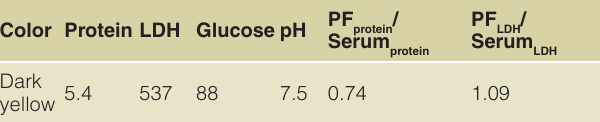
Table 2. Pleural fluid description. Ratio of the pleural fluid lactate dehydrogenase and protein to serum lactate dehydrogenase and protein (Light’s criteria meeting exudative etiology).